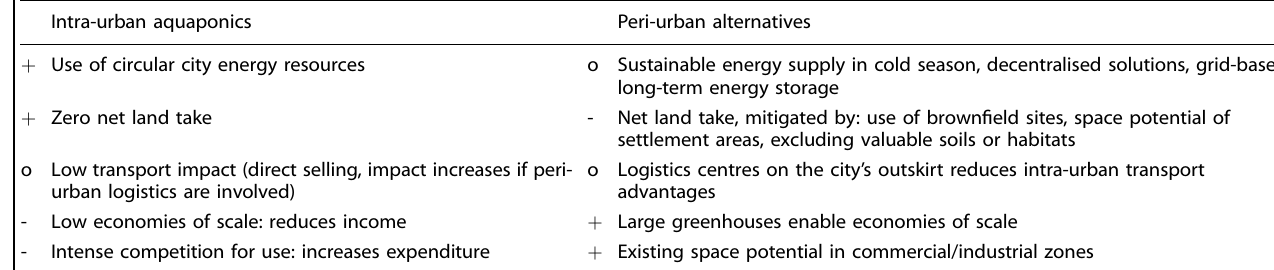
Table 5. Mesoscale policy goals ( + ), constraints (-), and boundary conditions (o) related to aquaponics in a city region. Intra-urban